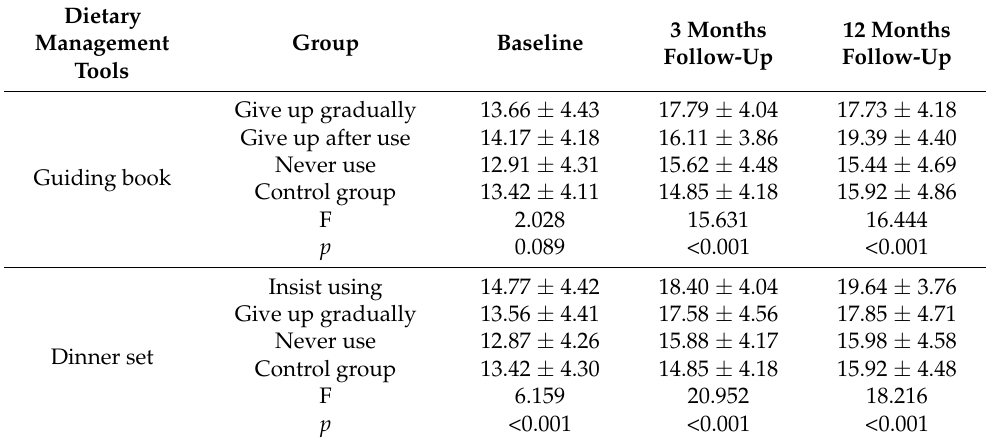
Table 2. Comparison of dietary skill scores among different subgroups (means ±